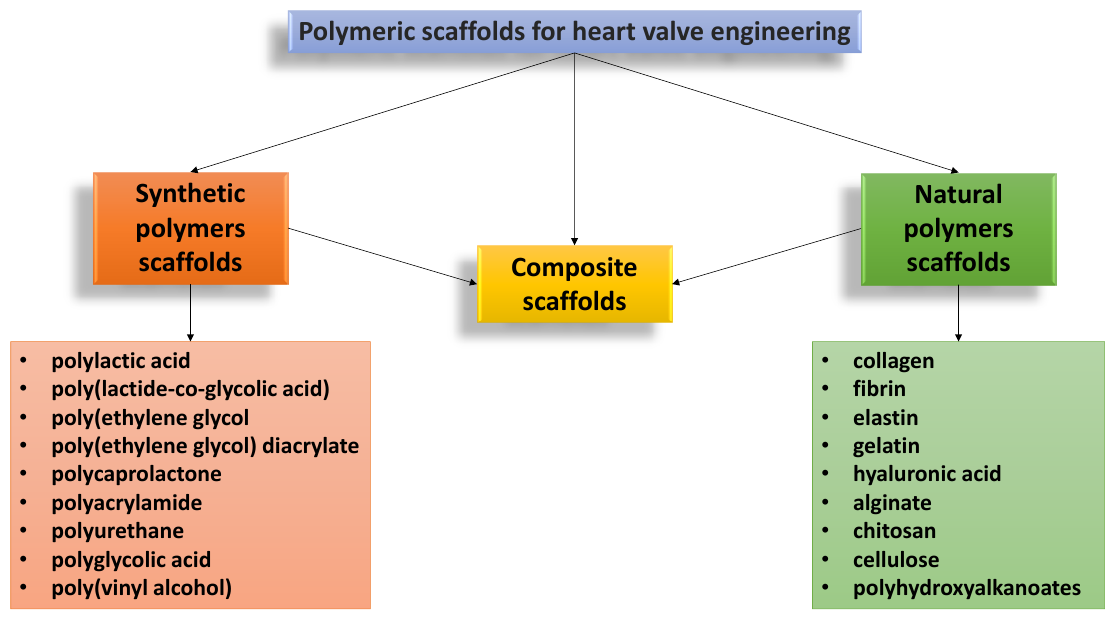
Figure 5. Polymeric scaffolds used in HVTE.